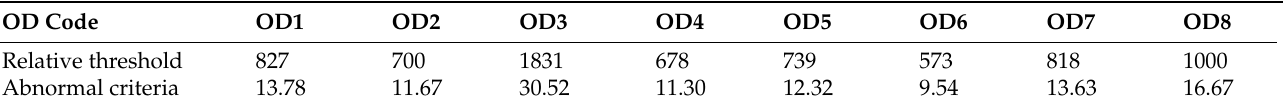
Table 1. Relative thresholds of ODs.